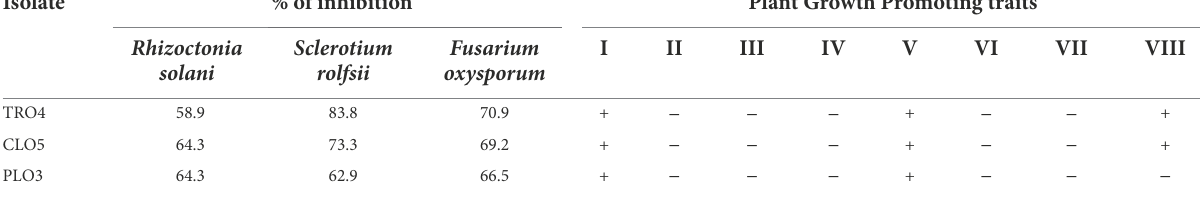
TABLE 4 Antifungal properties and PGP of selected bacterial endophytes.